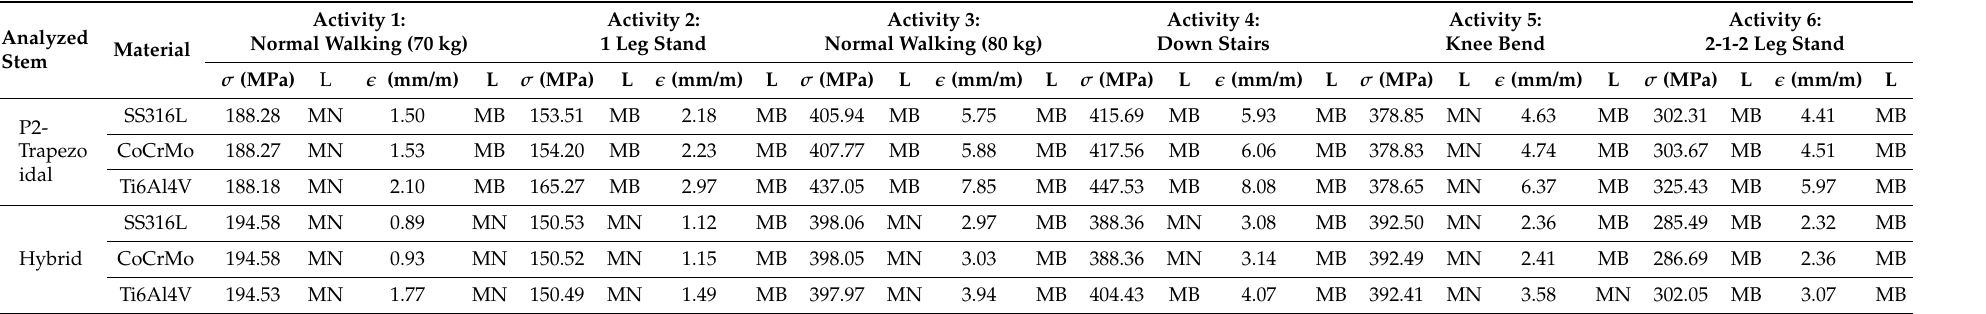
Table 6. Comparison of results between the best configurations analyzing the lower equivalent stresses and strains. Here, P2 represents the profile number. The locations (L) of the stresses and strains are given by MN = medial neck and MB = medial